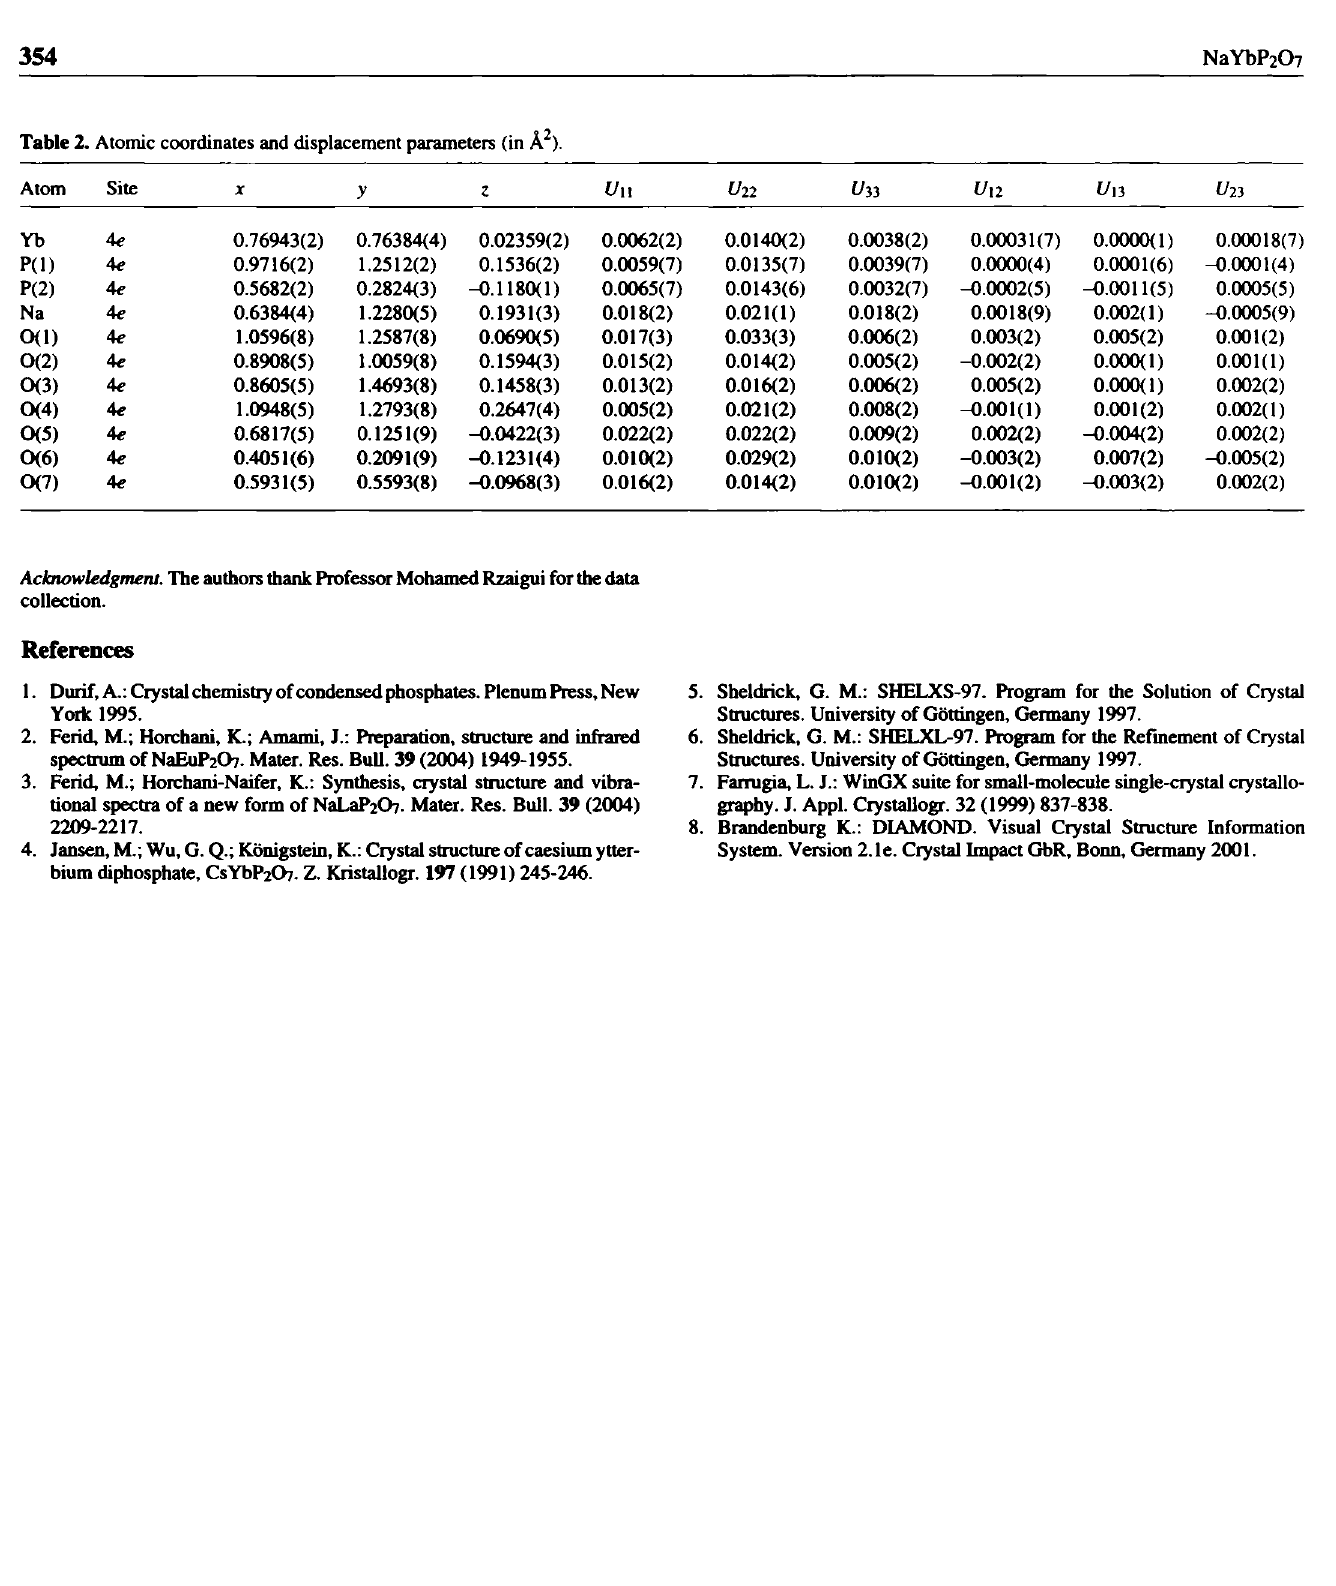
Table 2. Atomic coordinates and displacement parameters (in Â 2